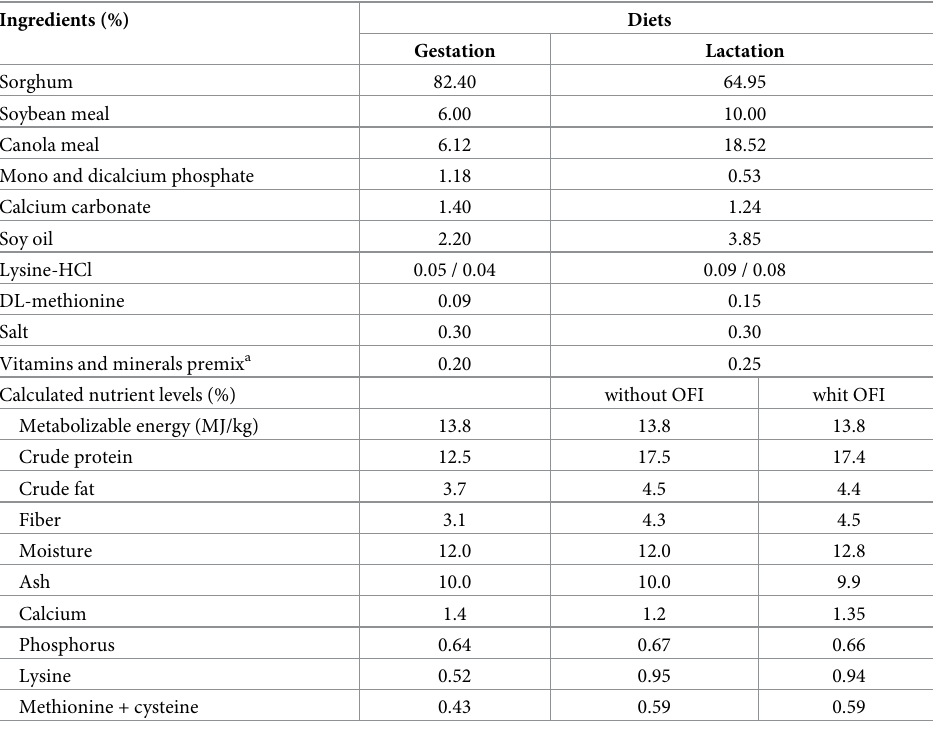
Table 1. Ingredients and nutritional composition of diets. Ingredients (%) Diets Gestation